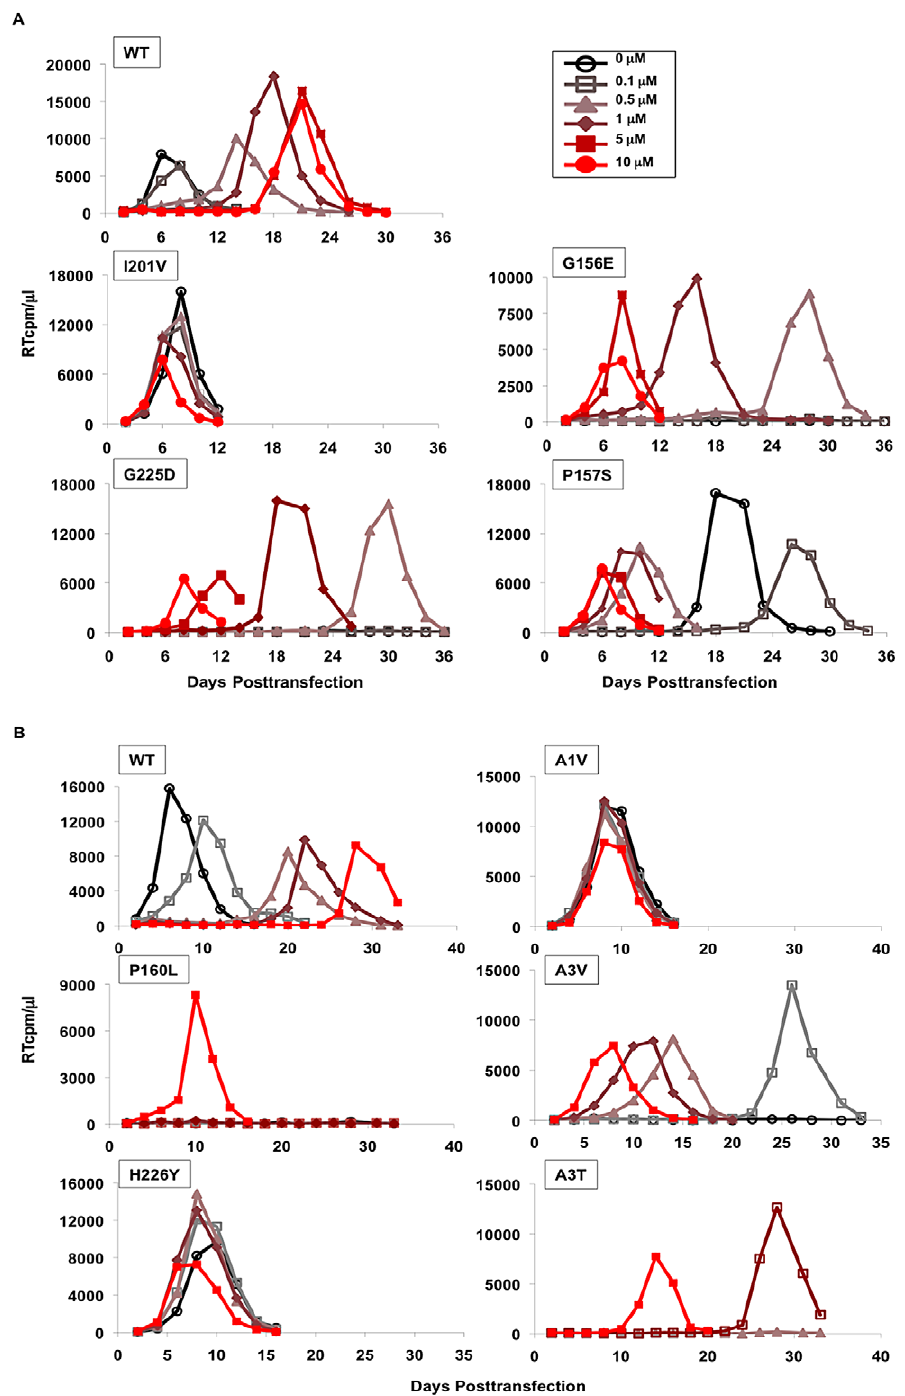
Figure 5. Replication kinetics of PF-46396-resistant mutants in the presence or absence of the compound. [A and B] The Jurkat T-cell line was transfected with WT or mutant pNL4-3 and propagated at the indicated concentration of PF-46396. Virus replication was monitored by RT activity, shown in cpm/ m l of culture medium. Note that WT is sensitive to PF-46396; CA-I201V, CA-A1V, and CA-H226Y are resistant; and CA-G156E, CA-P157S, CA-G225D, CA-P160L, SP1-A3V and SP1-A3T are PF-46396-dependent.